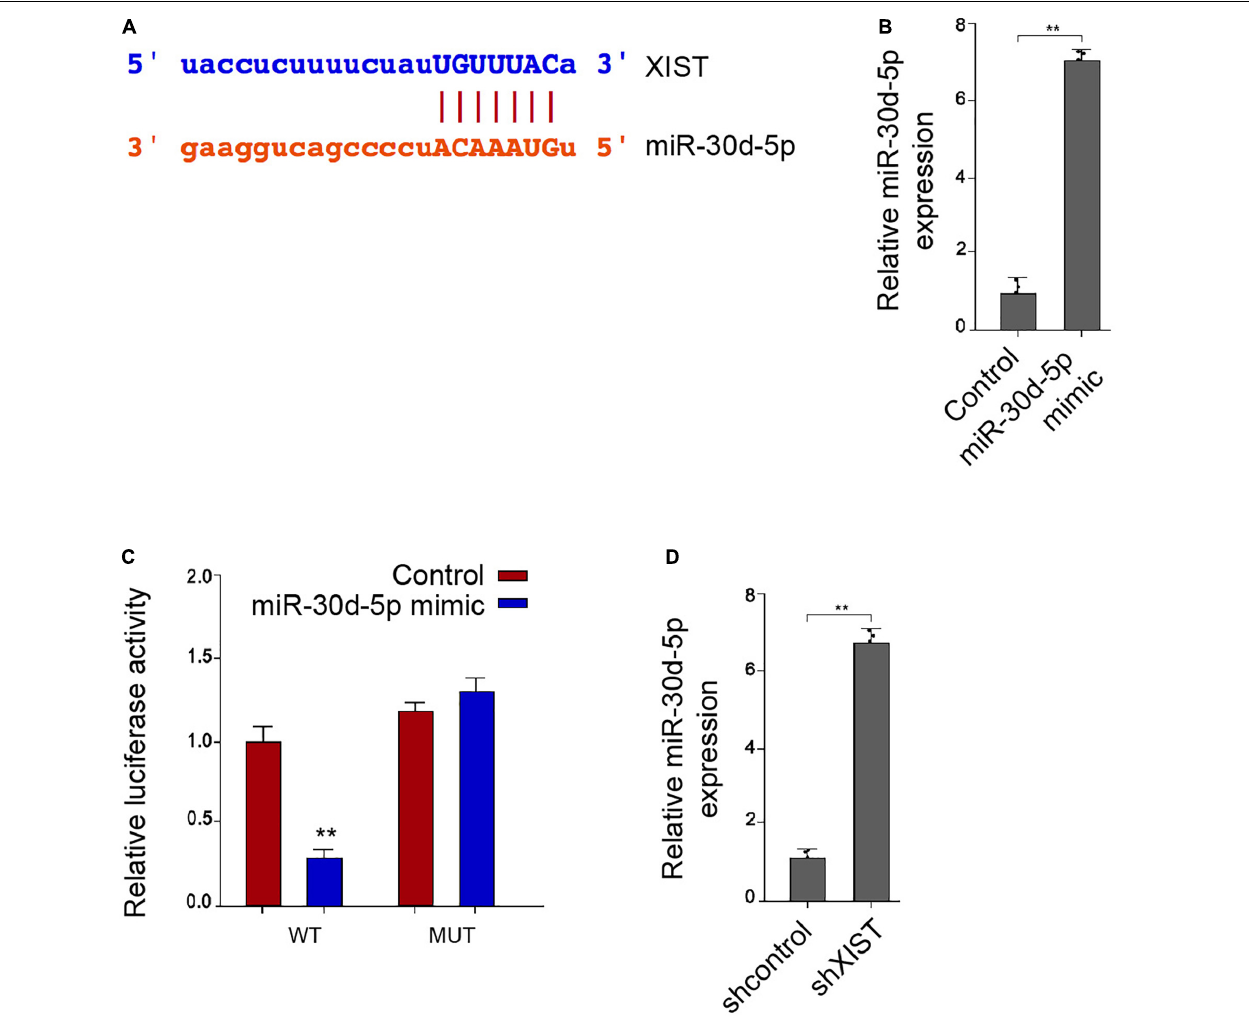
FIGURE 4 | XIST is able to sponge miR-30d-5p in the Schwann cells. (A) Bioinformatic analysis using ENCORI (http://starbase.sysu.edu.cn/index.php) shows the interaction of XIST with miR-30d-5p. (B,C) The RSC96 cells are treated with control mimic or miR-30d-5p mimic. (B) The expression of miR-30d-5p is detected by qPCR assays. (C) The luciferase activities of the wild-type XIST (WT) or mutant XIST (MUT) are detected by luciferase reporter gene assays. (D) The RSC96 cells are treated with control shRNA or XIST shRNA. The expression of miR-30d-5p is detected by qPCR assays. N = 3, mean ± SD, ** P < 0.01.